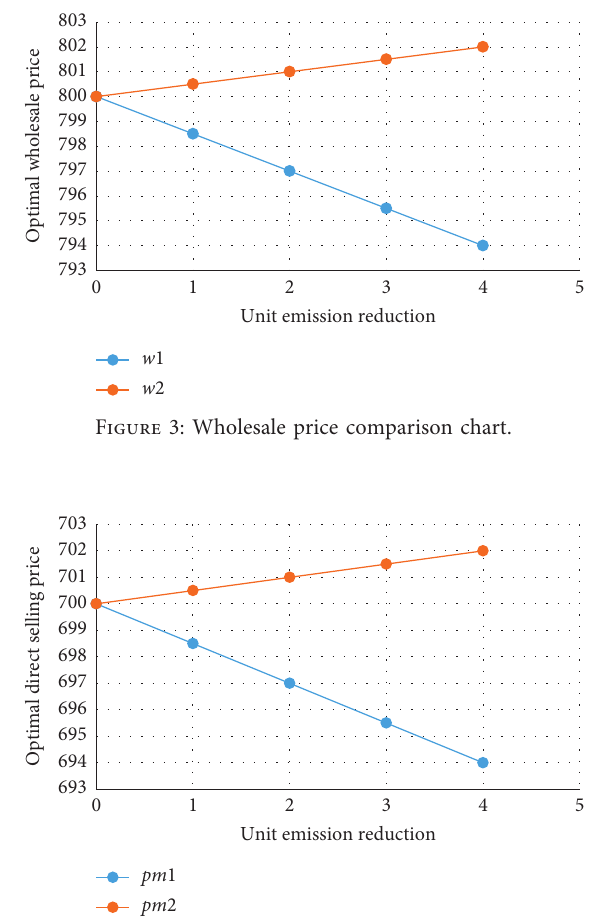
Figure 4: Direct selling price comparison chart.